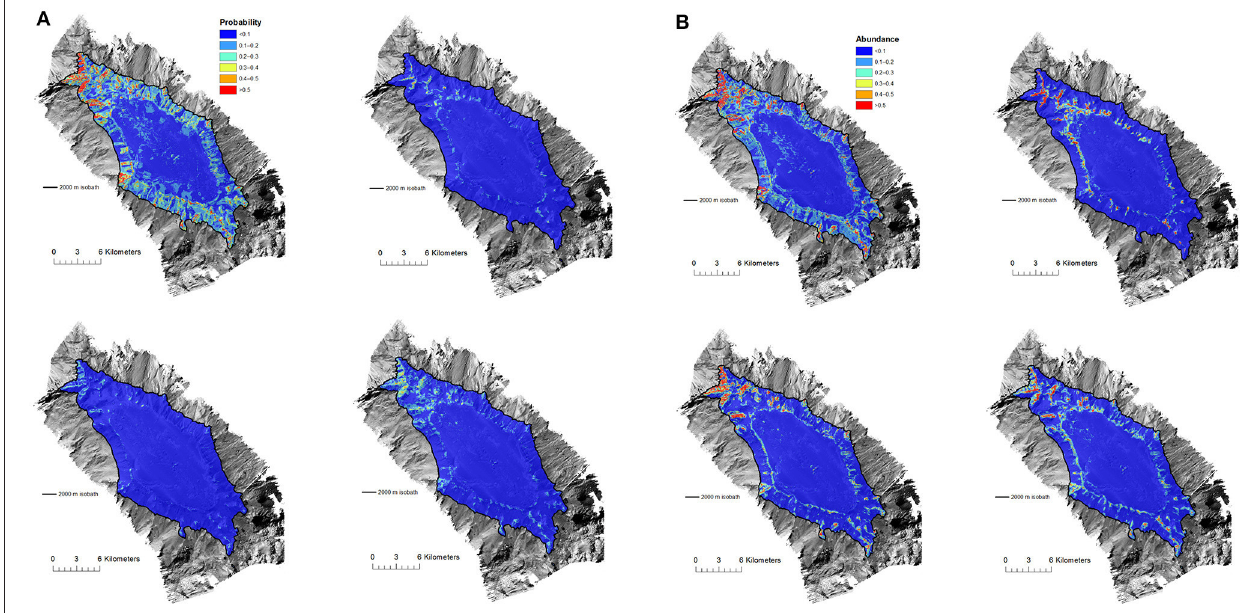
FIGURE 4 | (A) Forde Guyot. Model predictions of Solenosmilia variabilis habitat suitability (probability of presence) showing difference between model types (top left, BRT; top right, GAM; bottom left, RF; bottom right, Ensemble). Color-coded model probabilities are draped over the MBES bathymetry obtained during the survey. (B) Forde Guyot. Model predictions of Solenosmilia variabilis abundance (number of “live head” colonies per 25 × 25m model cell) showing difference between model types (top left, BRT; top right, GAM; bottom left, RF; bottom right, Ensemble). Color-coded model abundance estimates are draped over the MBES bathymetry obtained during the